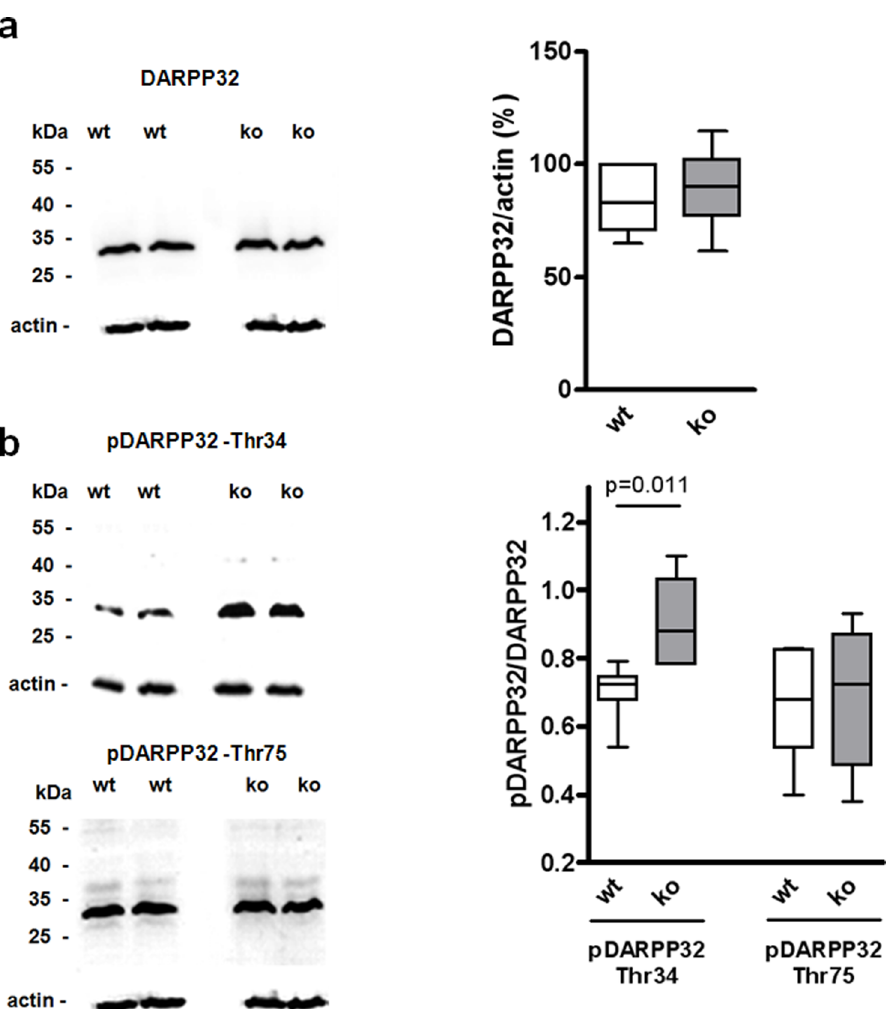
Figure 2. Striatal DARPP32-Thr34 phosphorylation is enhanced in RGS9-deficient mice. ( a ) Total DARPP32 from striatal homogenates of 3-month-old wt and RGS9-deficient mice was measured by Western blot quantification and normalized to actin. ( b ) DARPP32 phosphorylation at Thr34 and Thr75 is given relative to total DARPP32. Representative Western blots are shown, quantification was performed with n=6–8 per genotype.